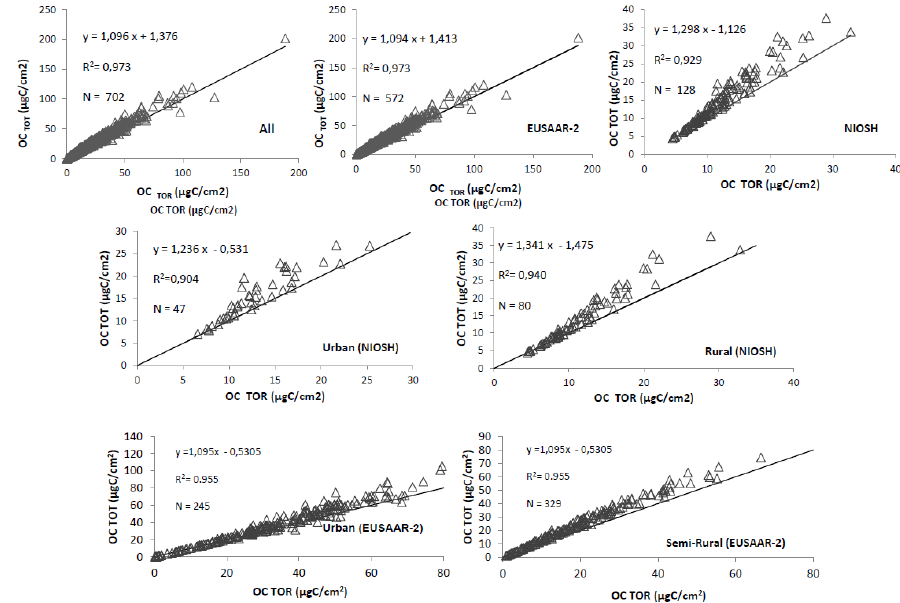
Figure 3. Comparison between reflectance and transmittance for OC for the different samples analysed using EUSAAR-2 (urban and semi-rural samples) or NIOSH (urban and rural samples) protocols. Slope coefficients (y = ax + b), correlation coefficients (R²) and the number of samples (N) are given for each graph.